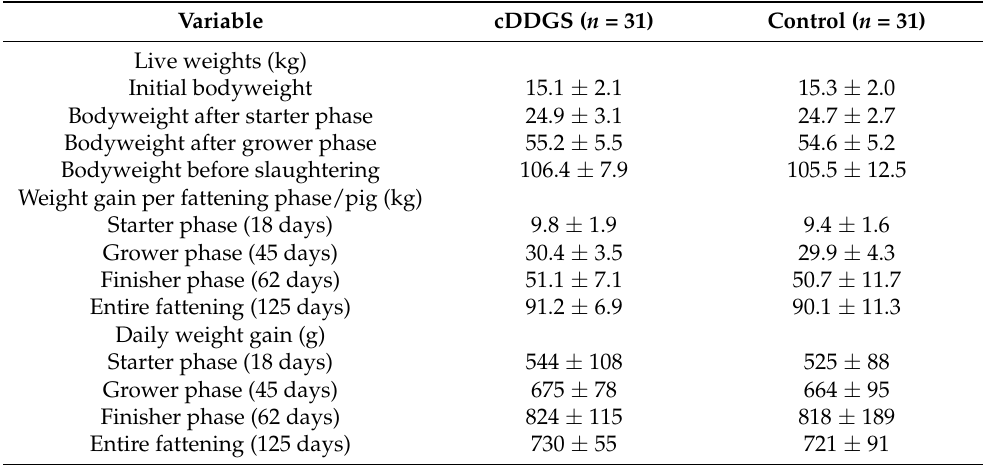
Table 3. Bodyweights at control weighing and weight gains of pigs during fattening (means ± SDs).